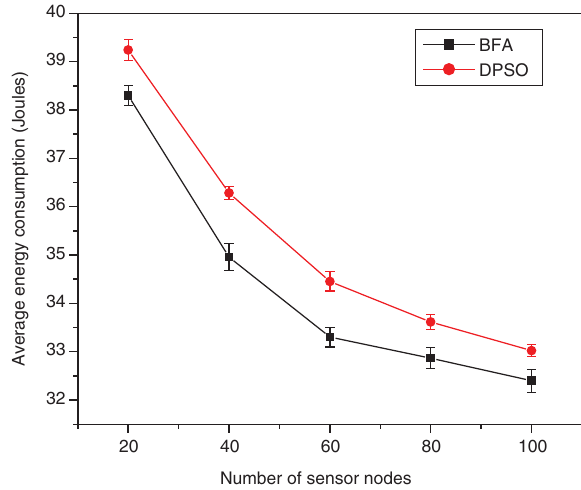
Figure 7: Sensor Nodes vs. Average Energy